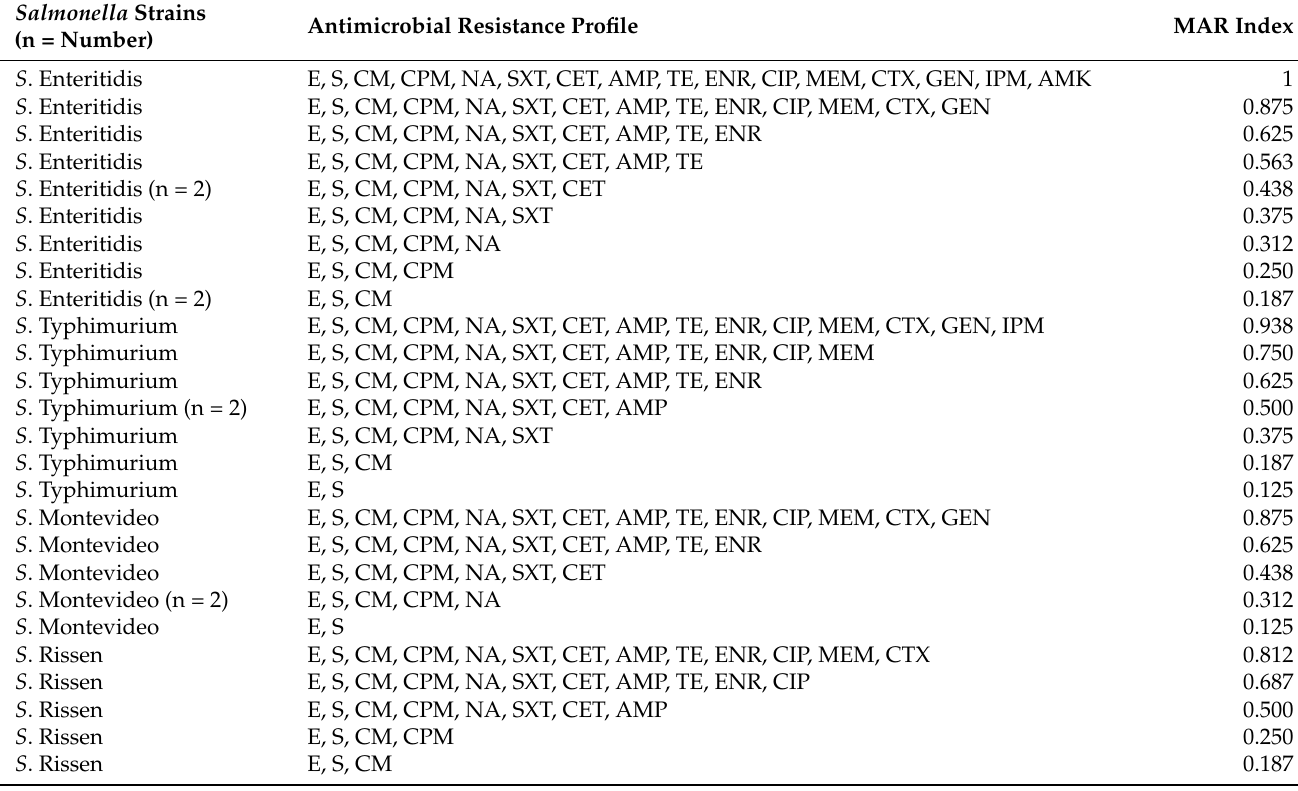
Table 3. Antimicrobial resistance profile and MARs indexes of the isolated Salmonella serovars ( n = 53) from buffalo